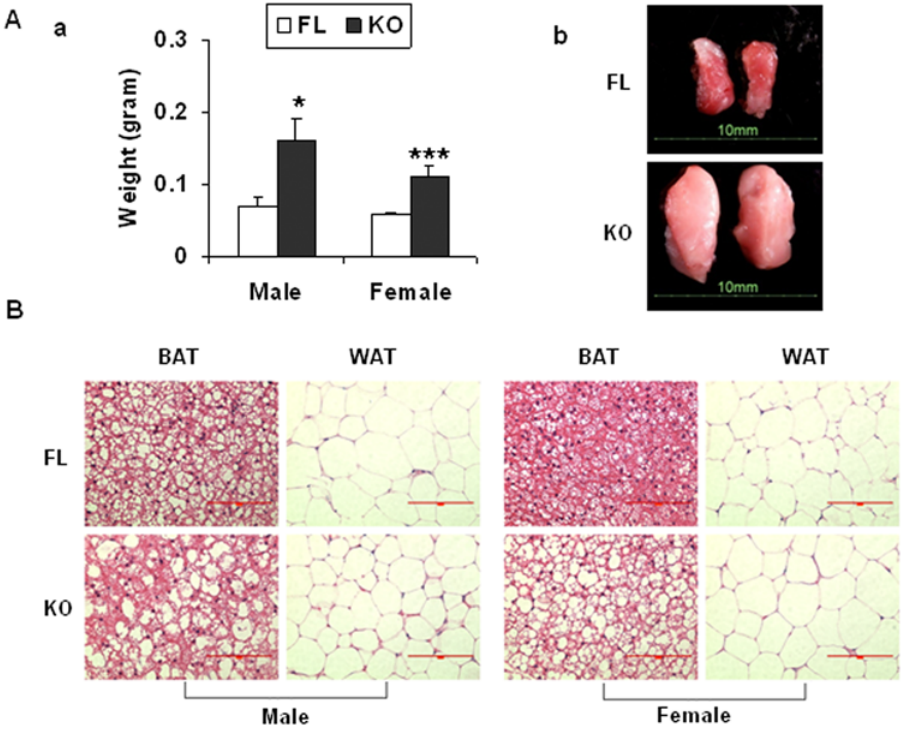
Figure 4. Brown adipose tissue abnormality in OGR1 KO mice in the mixed background. (A) Brown adipose tissues in the KO mice were larger than those in FL mice. (a) Weights of BAT (9 mice from FL and 9 mice from KO). (b) Representative appearance of BAT from FL and KO mice. (B) H & E staining of BAT and WAT in FL and KO mice. * represents a P value of , 0.05, and *** represents a P value of , 0.001. Scale bar=100 m m.